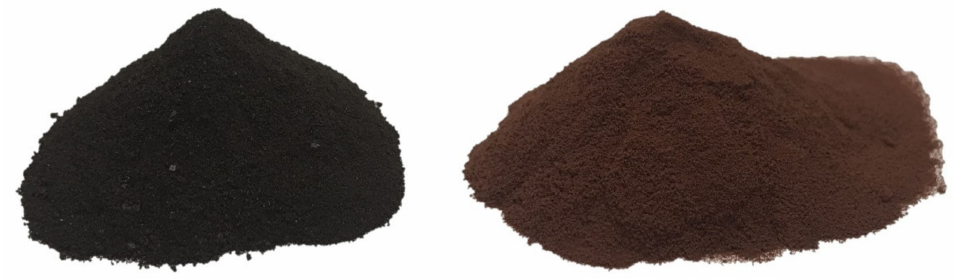
Figure 2. Powder of tannin–furanic polymer (TFP) ( left ) and mimosa tannin extract (MT) ( right